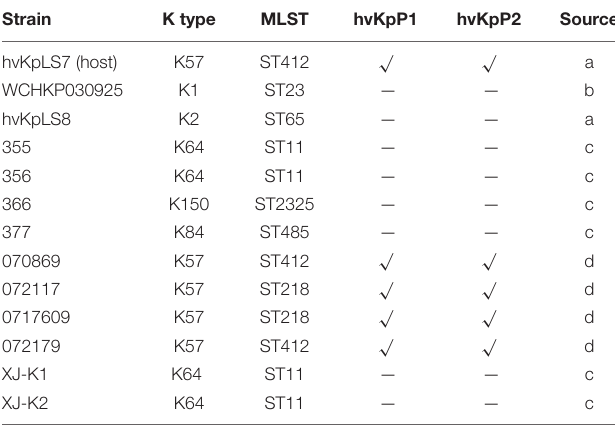
TABLE 1 | Host range of